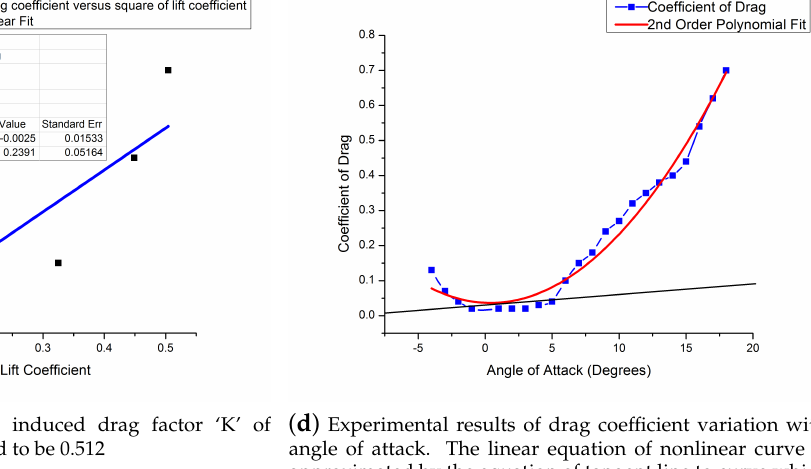
( c ) Experimentally obtained induced drag factor ‘K’ of FWMAV. Value of K was found to be 0.512